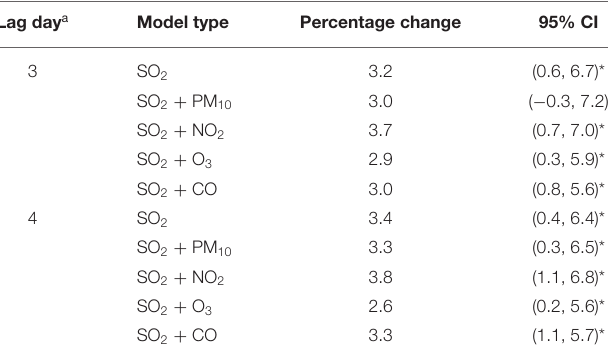
TABLE 4 | Percentage change (95% CI) of inpatient visits associated with 10 µ g/m 3 increase of SO 2 under multiple pollutant models. Lag day